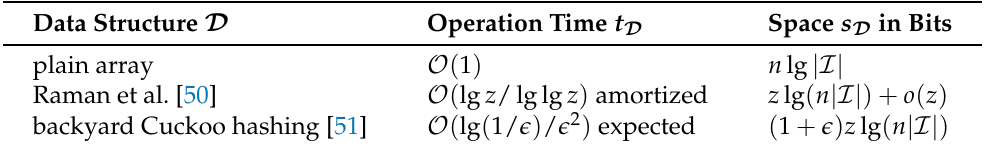
Table 2. Dynamic dictionary representations usable in our cpST approach (cf. Section 4.8) for mapping a light node represented in lg n bits to the lowest edge witness within its heavy path represented in lg bits. z : = z 78 [ ] denotes the number of LZ78 factors of T [ I ] , which is an upper |I| I bound on the number of edge witnesses. An operation is a lookup or an insertion. We are interested = o ( lg z ) (since, otherwise, the approach of Section 4.5 is favorable). (cid:101) in instances with t D a selectable